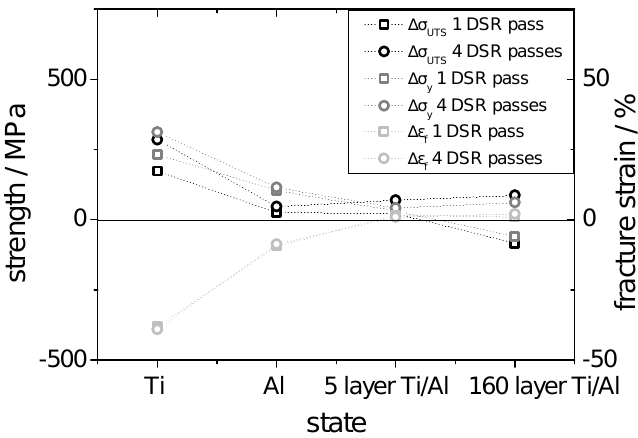
Figure 15. Effect of DSR on the mechanical properties. The chart shows the change of the ultimate tensile strength, yield strength and strain to failure for pure Al and Ti as well as for five-layered and 160-layered Ti/Al composite sheets before and after